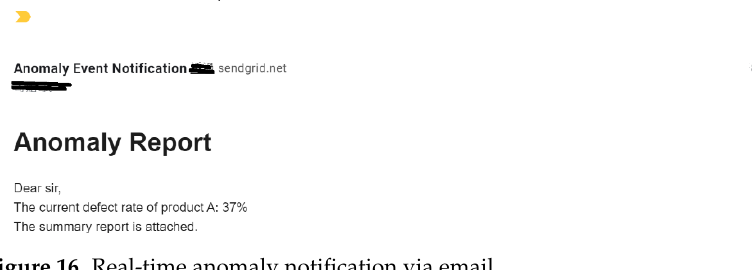
Figure 16. Real-time anomaly notification via email.